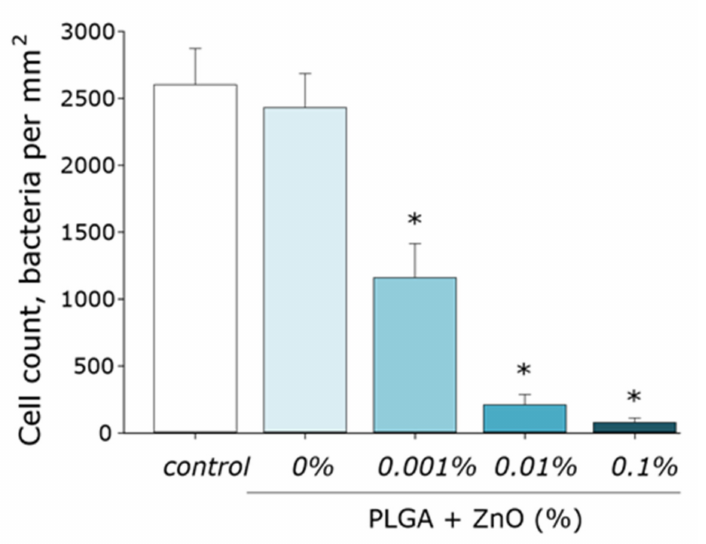
Figure 9. Influence of composite material based on PGLA and zinc oxide nanoparticles on the growth and development of E. coli . * indicate a significant difference at 5% level in comparison with the control ( p < 0.05). Data are presented as mean values and standard errors of